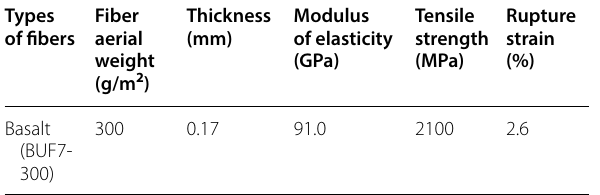
Table 3 Mechanical properties of the BFRP